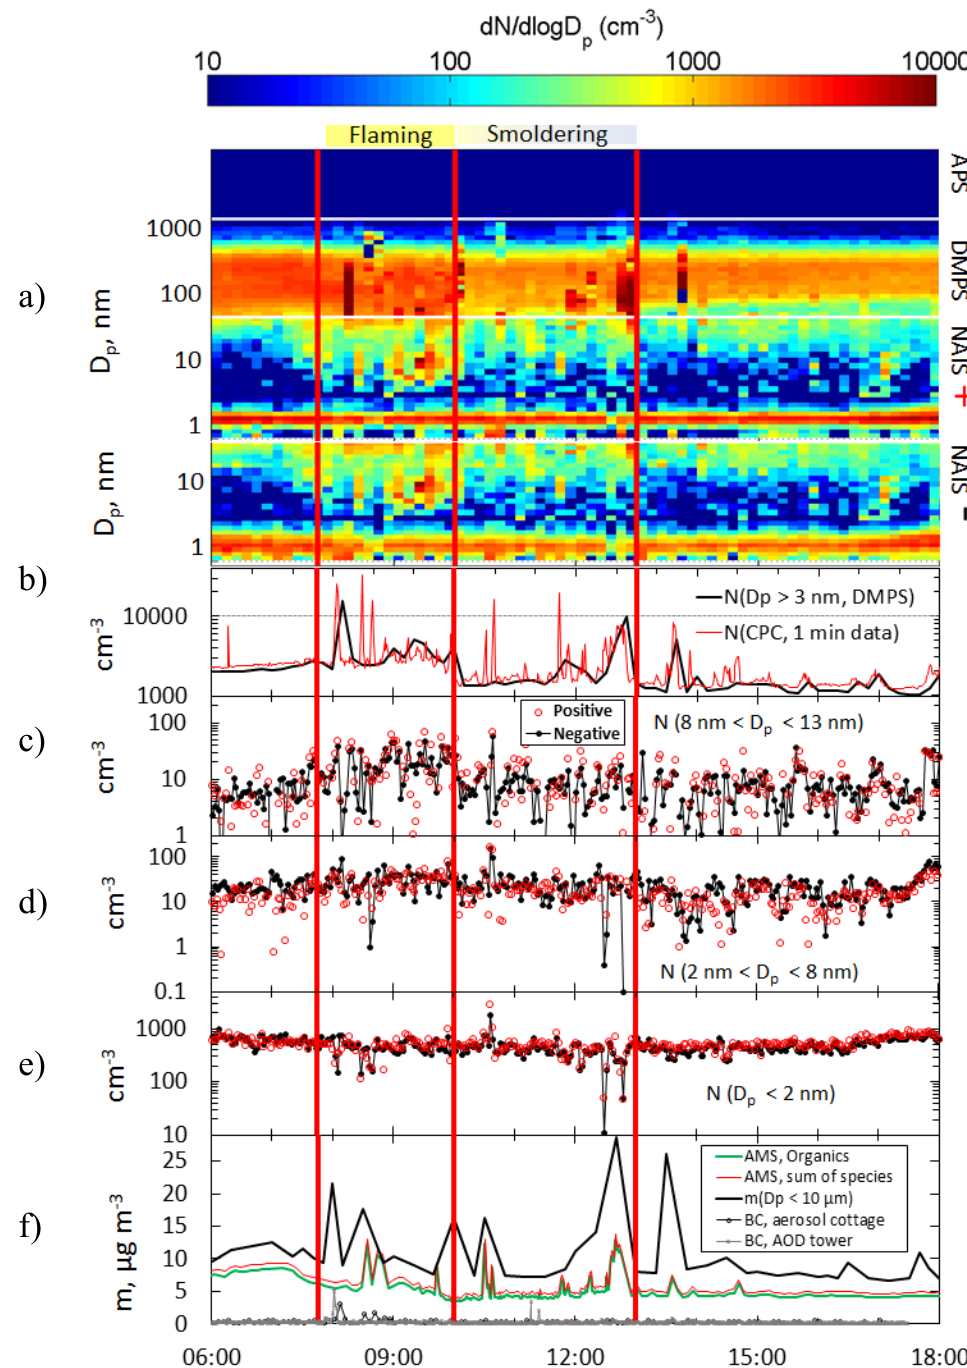
Fig. 9. Data of selected ground-based aerosol measurements at SMEAR II on 26 June 2009. (a) Particle number size distributions measured with the APS and the DMPS, and the positive and negative air ion size distributions measured with the NAIS. (b) Total particle number con- centrations measured with a CPC and integrated from the DMPS. (c–e) Air ion number concentrations from the NAIS data in three different size ranges. (f) Concentrations of organics and the sum of all compounds measured with an AMS, mass concentration of concentration of particles smaller than 10µm calculated from the size distributions measured with the DMPS and the APS using the density of 1.5gcm − 3 , and black carbon concentration at two